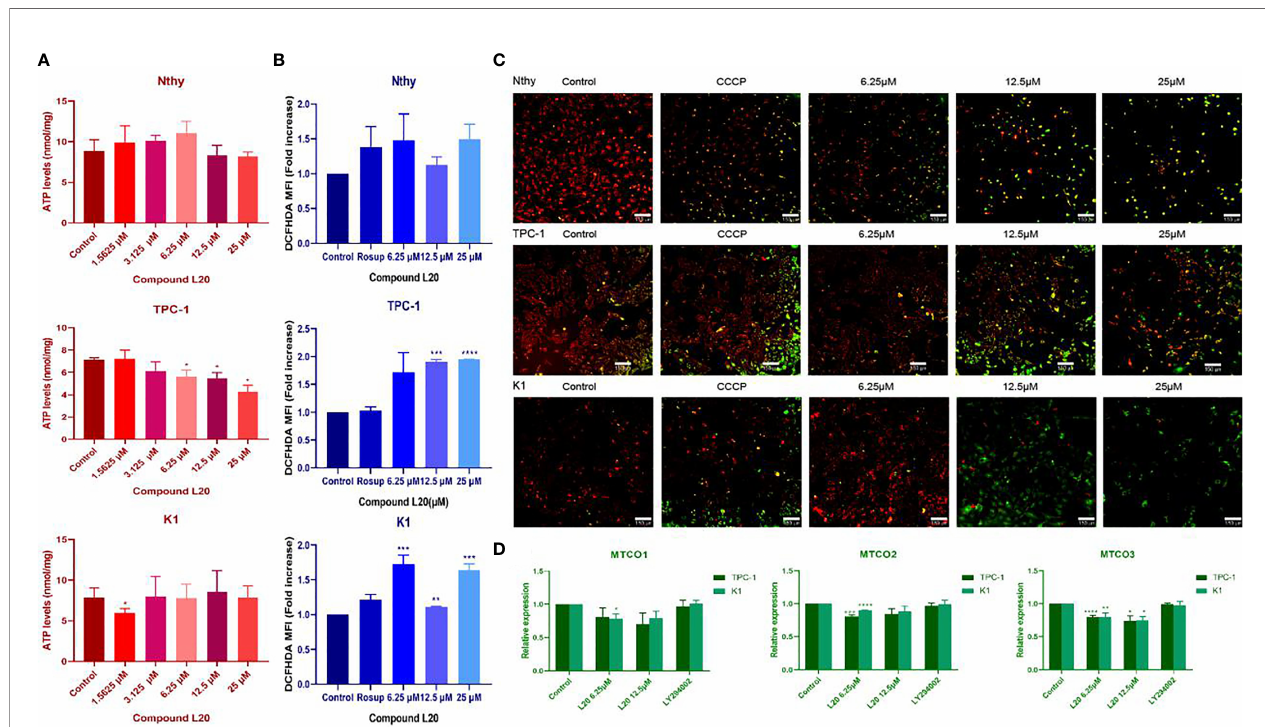
FIGURE 3 | Effects of Mito-Fu L20 on mitochondrial biogenesis in normal thyroid cells and papillary thyroid carcinoma cells. Treatment with different concentrations of Mito-Fu L20 signi fi cantly altered (A) cellular ATP levels, (B) ROS production, (C) mitochondrial membrane potential, and (D) gene expression of complex IV subunits in papillary thyroid carcinomas (TPC-1 and K1 cells). (A) ATP levels were signi fi cantly decreased in treated TPC-1 cells, in a dose-dependent manner. (B) ROS production in PTC was elevated after treatment with Mito-Fu L20, except in the K1 group treated with 12.5 m M Mito-Fu L20. (C) Red signals indicate normal cells and green signals indicate apoptosis. Thus, in the overlapping images, the yellow and red signals indicate normal cells, whereas the green signals indicate apoptosis. The higher concentration of Mito-Fu L20 was chosen as the intervention, and more green signals were detected (scale bar: 150 m m). (D) Expression levels of complex IV subunits, including MTCO1, MTCO2, and MTCO3 were determined by RT-qPCR. These genes were signi fi cantly inhibited after Mito-Fu L20 intervention, but inhibitory effects for MTCO3 were found only with an increased drug concentration. *P < 0.05, **P < 0.01, ***P < 0.005, ****P < 0.001. Values are means of three replicates, and all experiments were performed at least three